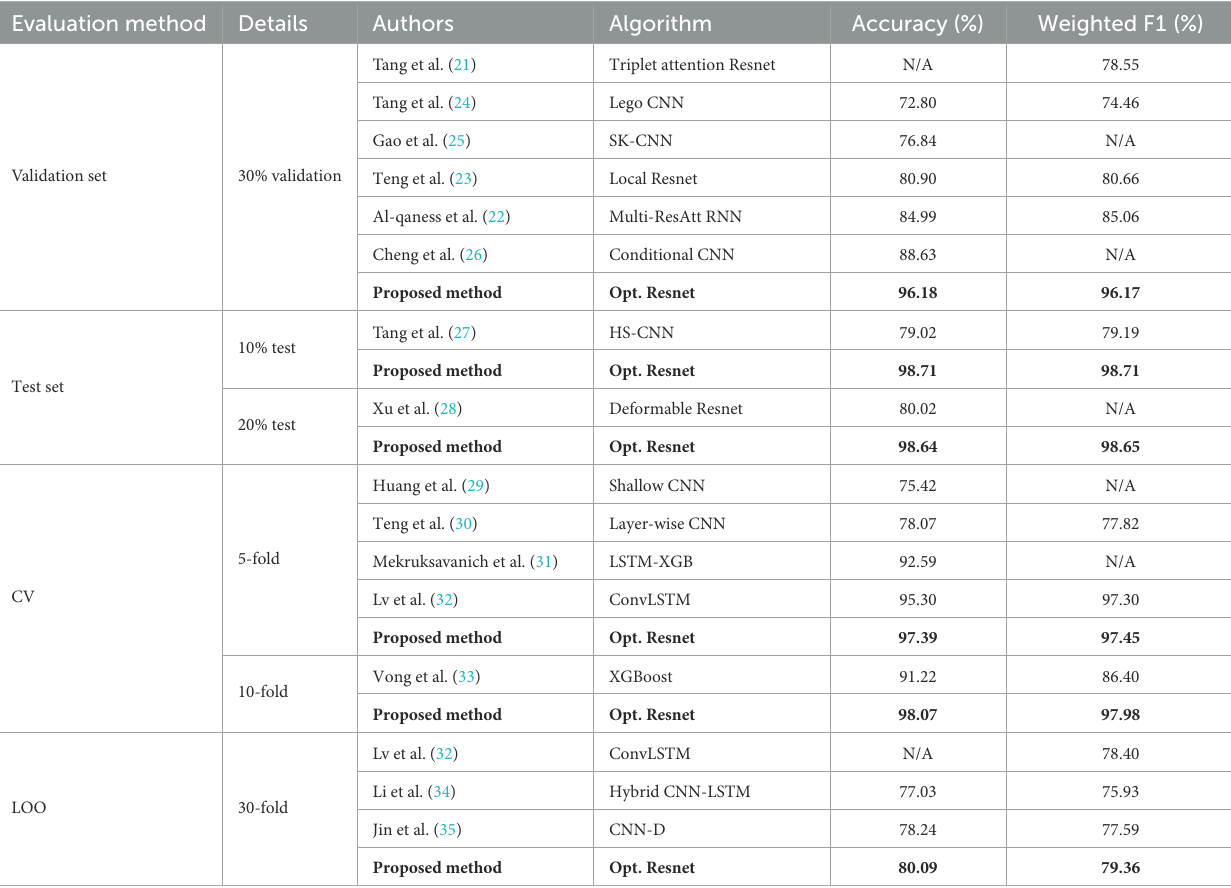
TABLE 4 Benchmark of multi-class classification on the UniMiB-SHAR dataset.